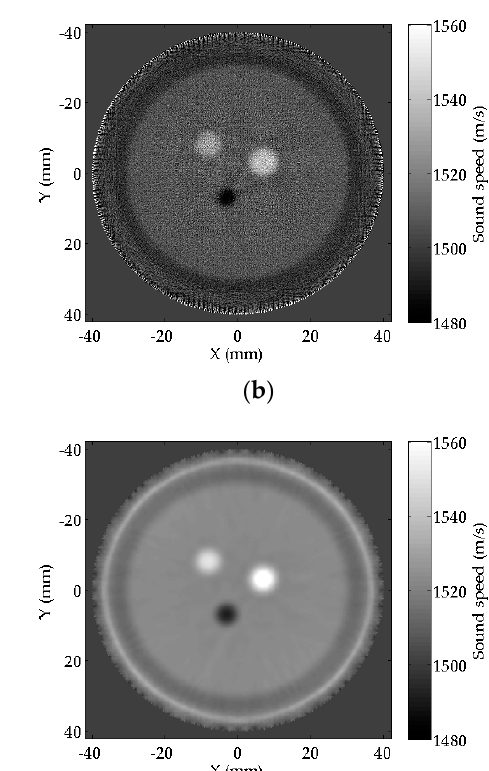
Table 1. The design of the numerical breast phantom.